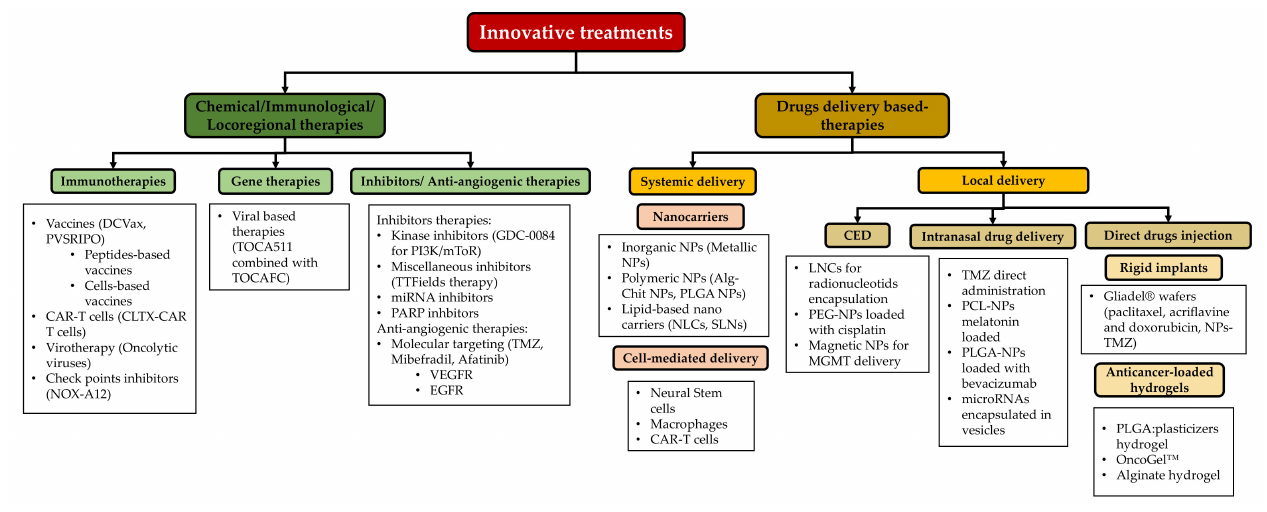
Figure 4. Summary of some different innovative treatments for GBM. DCVax: dendritic cells vac- cine; PVSPIRO: recombinant nonpathogenic polio-rhinovirus chimera; CAR-T: chimeric antigen receptor T cell; CLTX-CAR T: chlorotoxin-chimeric antigen receptor T cell; NOX-A12: olaptesed pegol; TOCA511: vocimagene amiretrorepvec; TOCAFC: toca 511 (vocimagene amiretrorepvec) + FC (5-fluorouracil); GDC-0084: paxalisib; TTFields: tumor-treating fields; PARP: poly (ADP-ribose) poly- merase; Alg: alginate; Chit: chitosan; PLGA: poly D,L-lactic-co-glycolic acid; NLCs: nanostructured Lipid Carriers; SLNs: solid lipid nanoparticles; LNCs: lipid nanocapsules; PEG: polyethylene glycol; PCL: